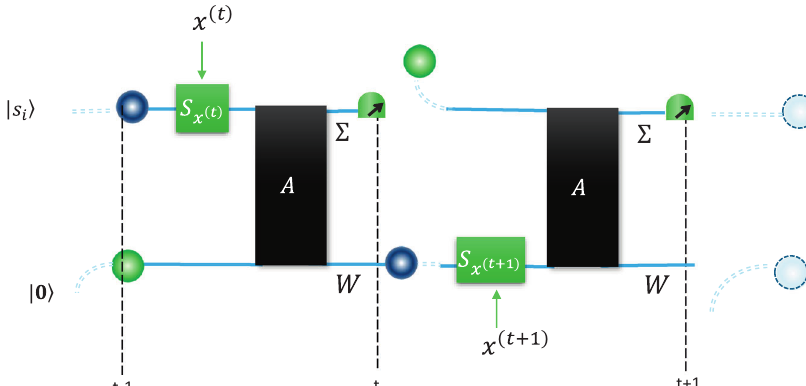
Fig. 3 The quantum circuit that illustrates how a quantum transducer initialized in | s i 〉 at time t − 1, simulates the future behavior, when supplied with an input sequence x ( t ) x ( t +1) … . Upon receiving x at time-step t , it applies a selection operator S x : s i j i ! s x quantum operation A that takes each s x by | s k 〉 (This is always possible with suitable ancilla, see methods). Σ is emitted as output, while W is retained as the quantum causal state at the next time-step. Measurement of Σ in the { | y 〉 } basis by any outside observer yields outcome y ( t ) . Iterating this procedure then